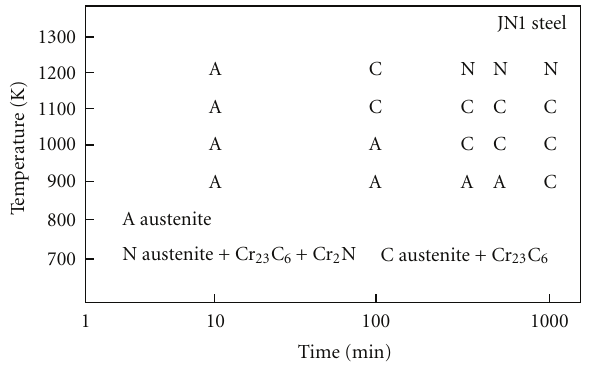
Figure 12: Time-temperature precipitation diagram of JN1